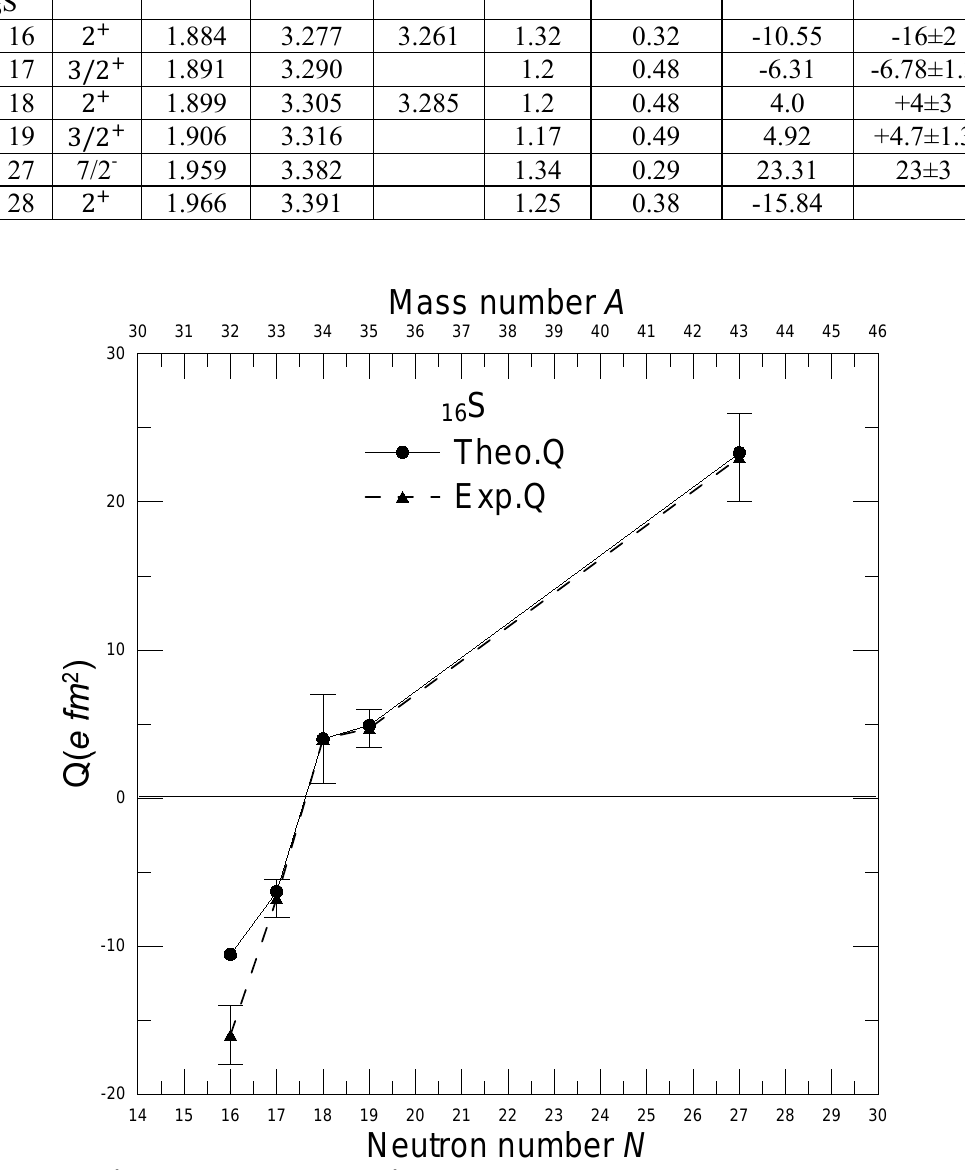
Fig. 4: Experimental [18] and theoretical quadrupole moments versus neutron number for S